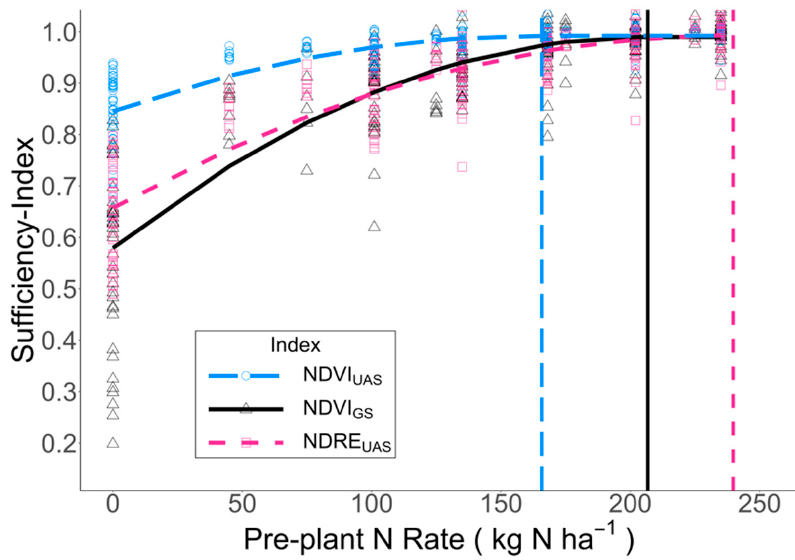
Figure 6. The relationship between pre-plant N rate and GreenSeeker (GS) Normalized Difference Vegetation Index (NDVI GS) Sufficiency-Index (SI), unmanned aircraft system (UAS) Normalized Difference Red-Edge Index (NDRE UAS ) SI, and NDVI UAS SI measured at panicle initiation (PI) rice growth stage as described by quadratic-plateau linear regression models. The vertical lines represent the N rate where the relationship for each SI reaches a plateau (i.e., the point of saturation for each index).